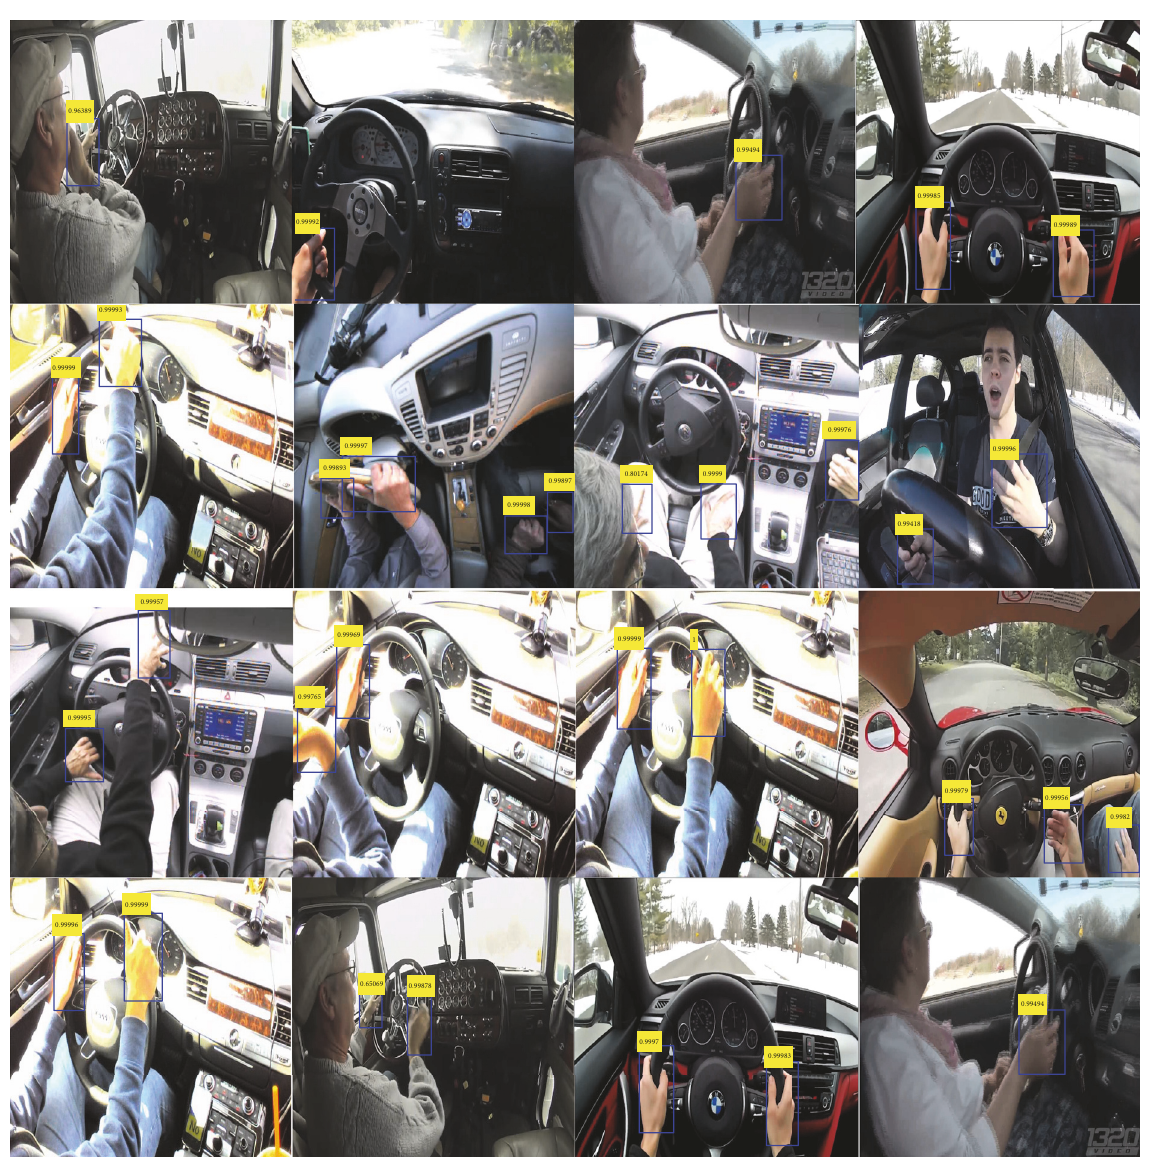
Figure 14: Correctly detected examples on the VIVA Hand Detection Challenge: The red boxes are the annotated hand positions and the blue boxes are the detected boxes with corresponding label tags showing the detection score colored in yellow.